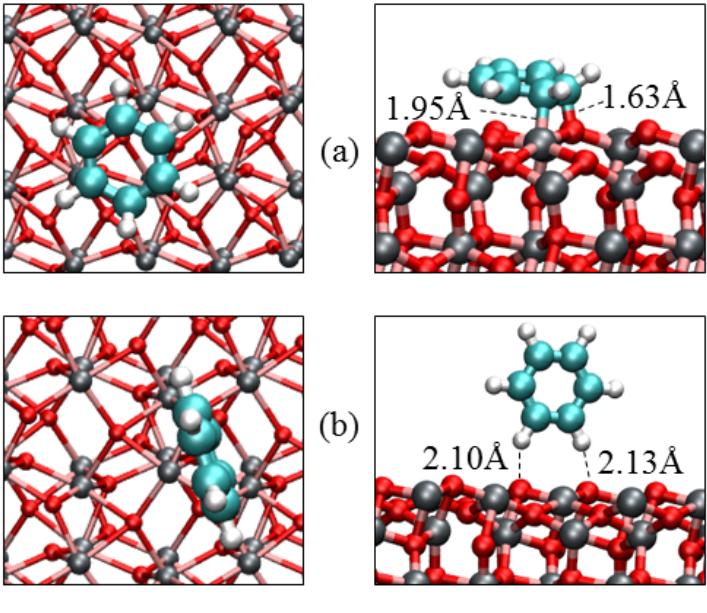
Figure 11. Relaxed adsorption geometries of the benzene on α-Fe and vertical geometries are shown in ( a ) and ( b ) respectively. The top ( left ) and side ( right ) views are shown. Color scheme: Fe = grey; O = red; C = green and H =